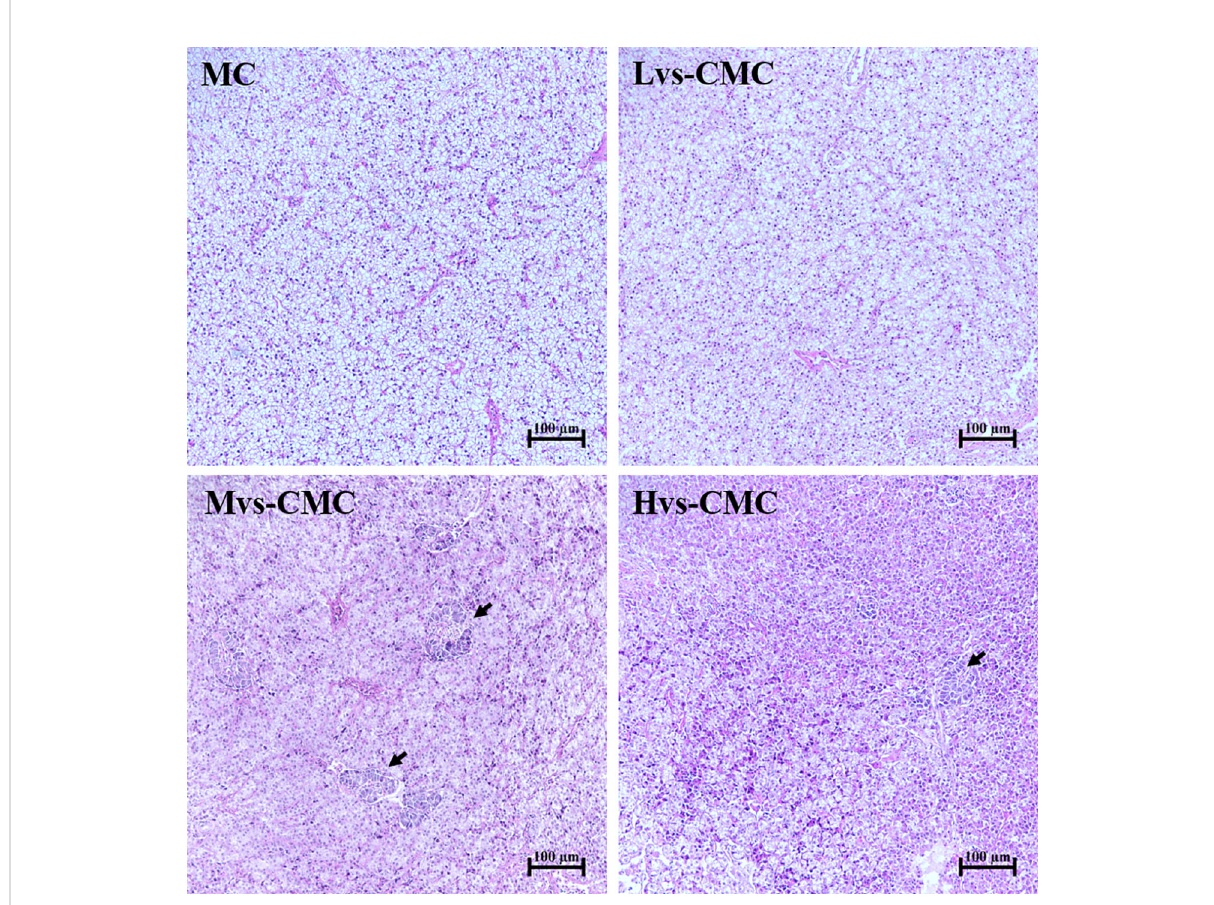
TABLE 7 Effects of increasing dietary viscosity on the hindgut morphology of juvenile largemouth bass.